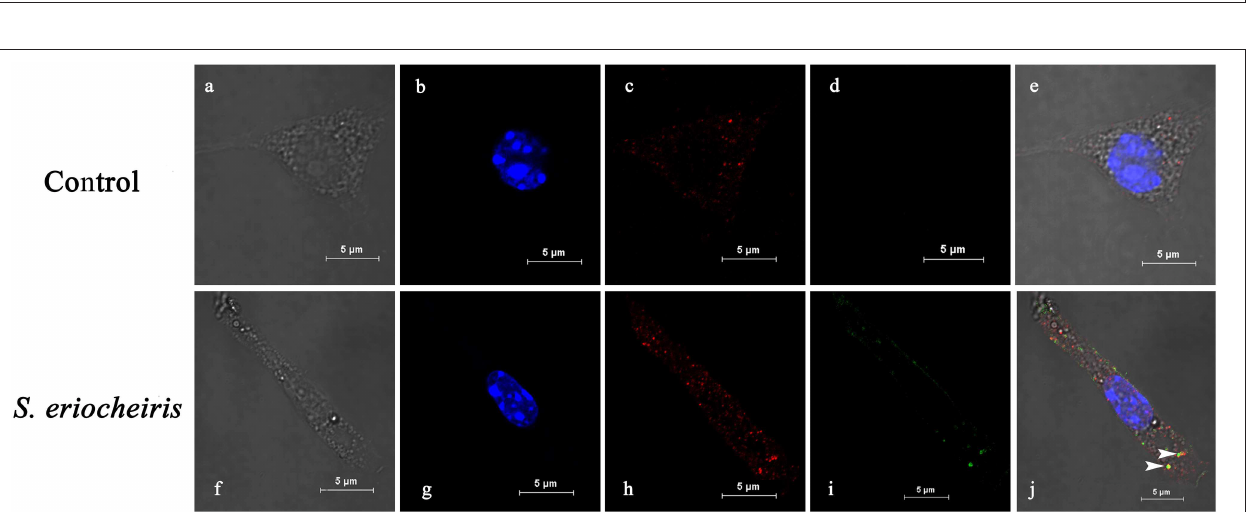
Frontiers in Immunology |